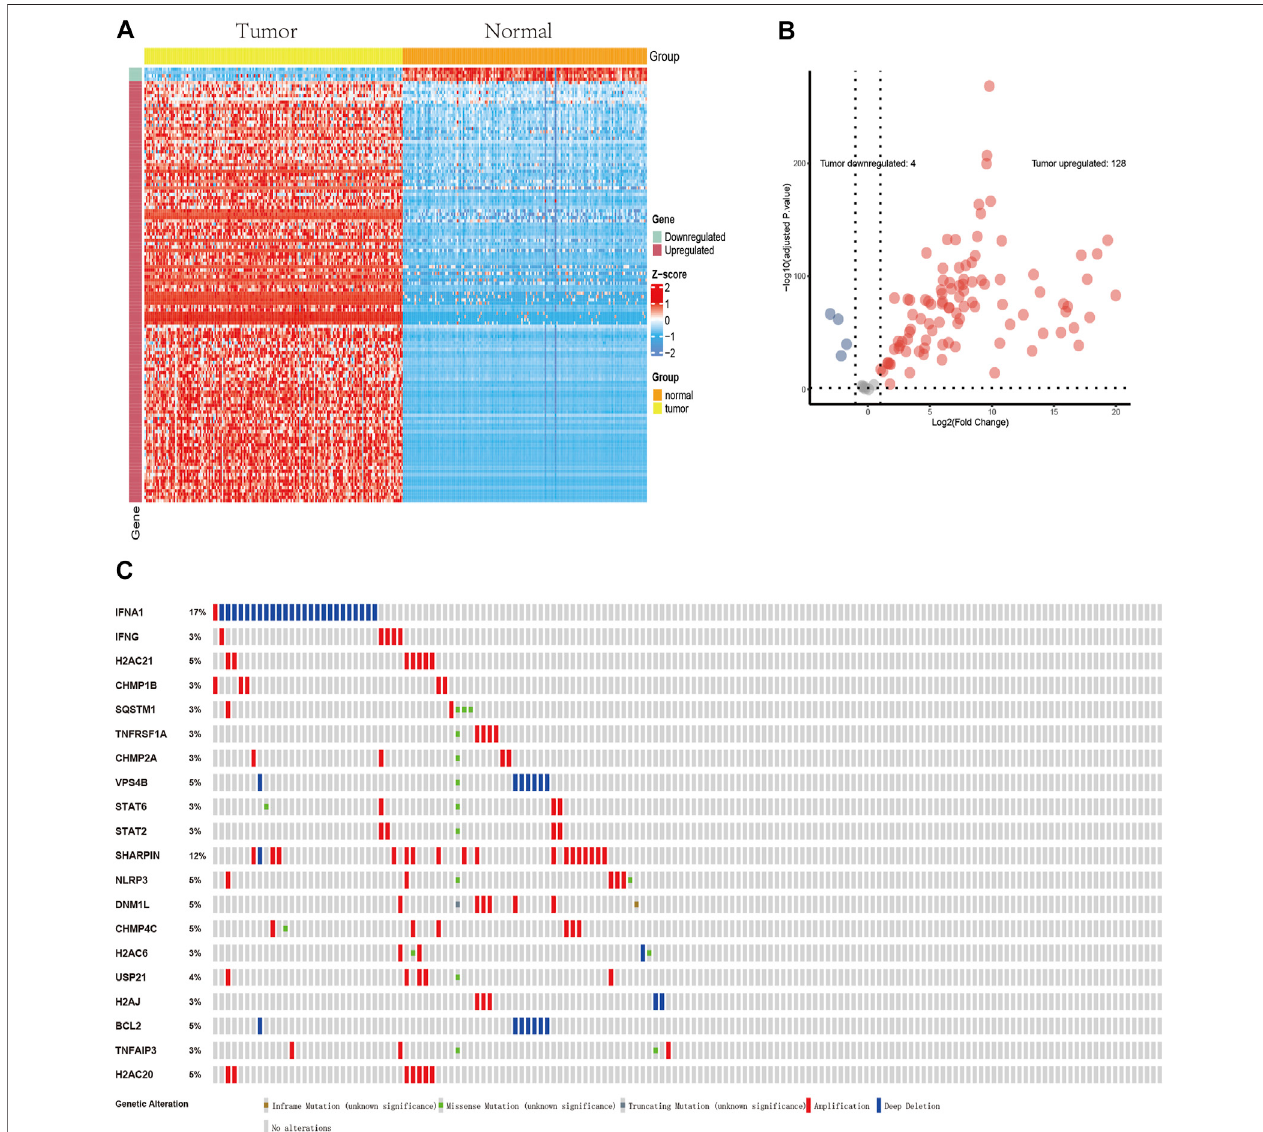
FIGURE 2 | Pro fi les of differentially expressed NRGs. (A) A heatmap of 132 differentially expressed NRGs. (B) A volcano plot showing the differentially expressed NRGs. 128 red dots indicate upregulated NRGs and four blue dots indicate downregulated NRGs in PCa compared with normal tissues. (C) Pro fi les of mutations in NRGs. A total of 20 genes exhibited a mutation rate ≥